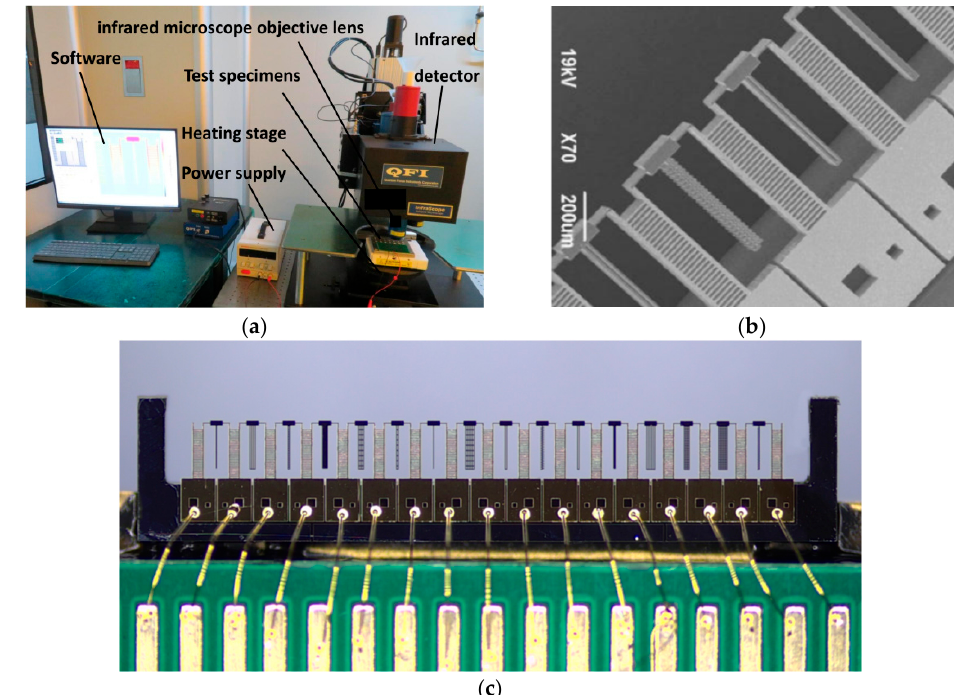
Figure 1. Experimental setup and test specimens: ( a ) Experimental System of micro-infrared thermometry; ( b ) electron micrograph of test specimens; ( c ) microscopic imaging of test specimens.